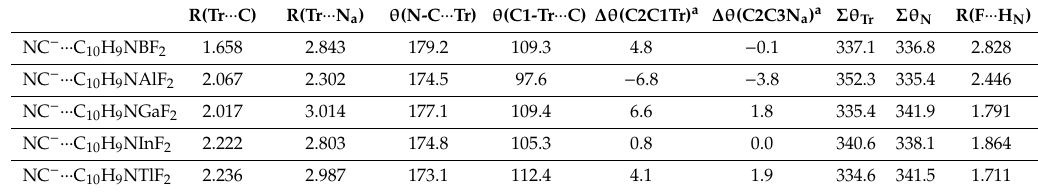
Table 7. Structural parameters (distances in Å, angles in degrees) in complexes of C 10 H 6 NH 2 TrF 2 with NC − calculated at the MP2 / aug-cc-pVDZ level of theory.